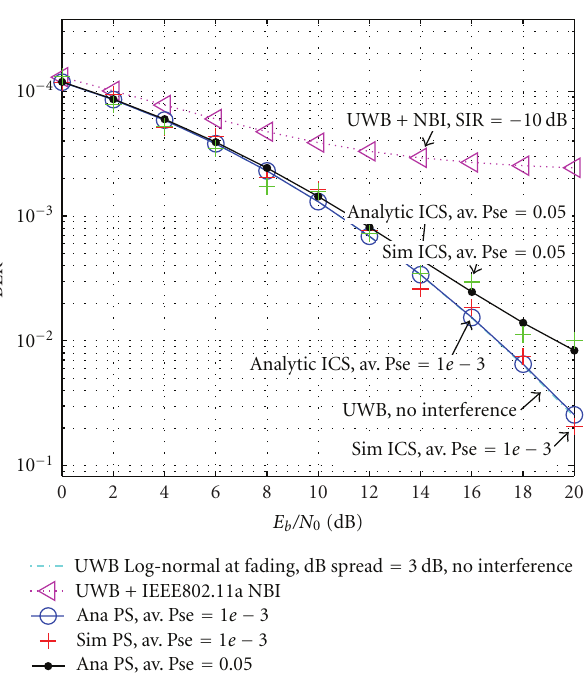
Figure 4: Simulation and analytical performance comparison of the ICS, dB-spread = 3dB and SIR = − 10